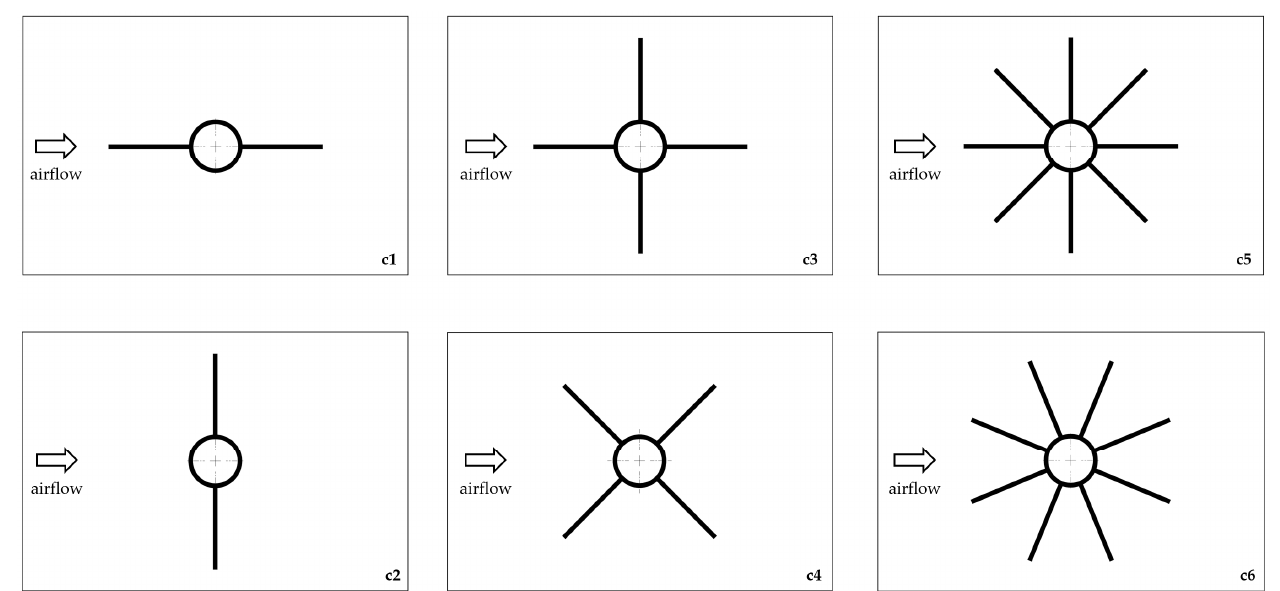
Figure 6. Analyzed cases ( c1 – c6 ) of profiles orientation.